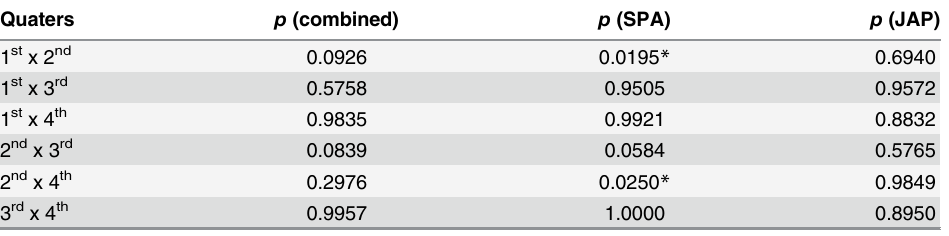
Table 4. P-values of Two-sample Kolmogorov-Smirnov tests comparing CPUE values for all quarters of the